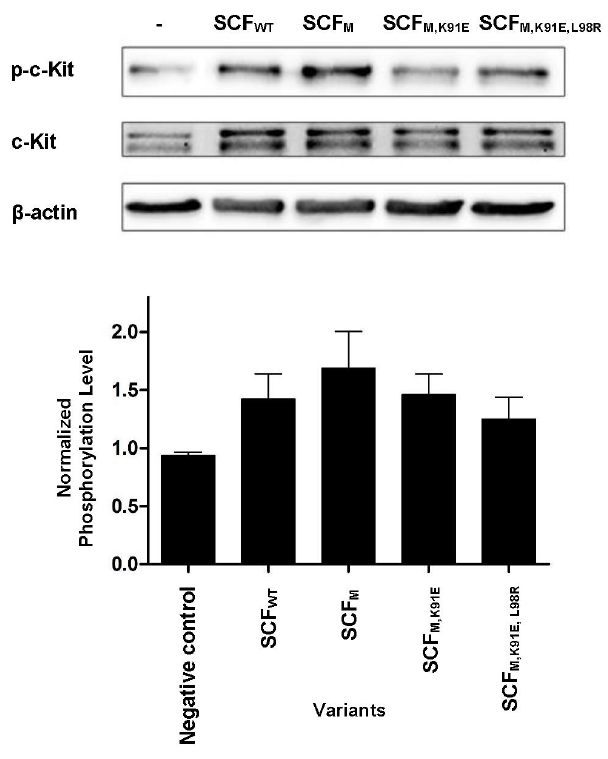
Figure 5. SCF variants activate c-Kit on primary human umbilical vein endothelial cells (HUVECs). HUVECs were incubated with SCF proteins (SCF WT , SCF M , SCF M,K91E or SCF M,K91E,L98R ) at a concentration of 250 nM. c-Kit phosphorylation levels were normalized to the expression levels of c-Kit (second row) and to β -actin levels (third row). Values are means ± SEM of independent measurements performed in